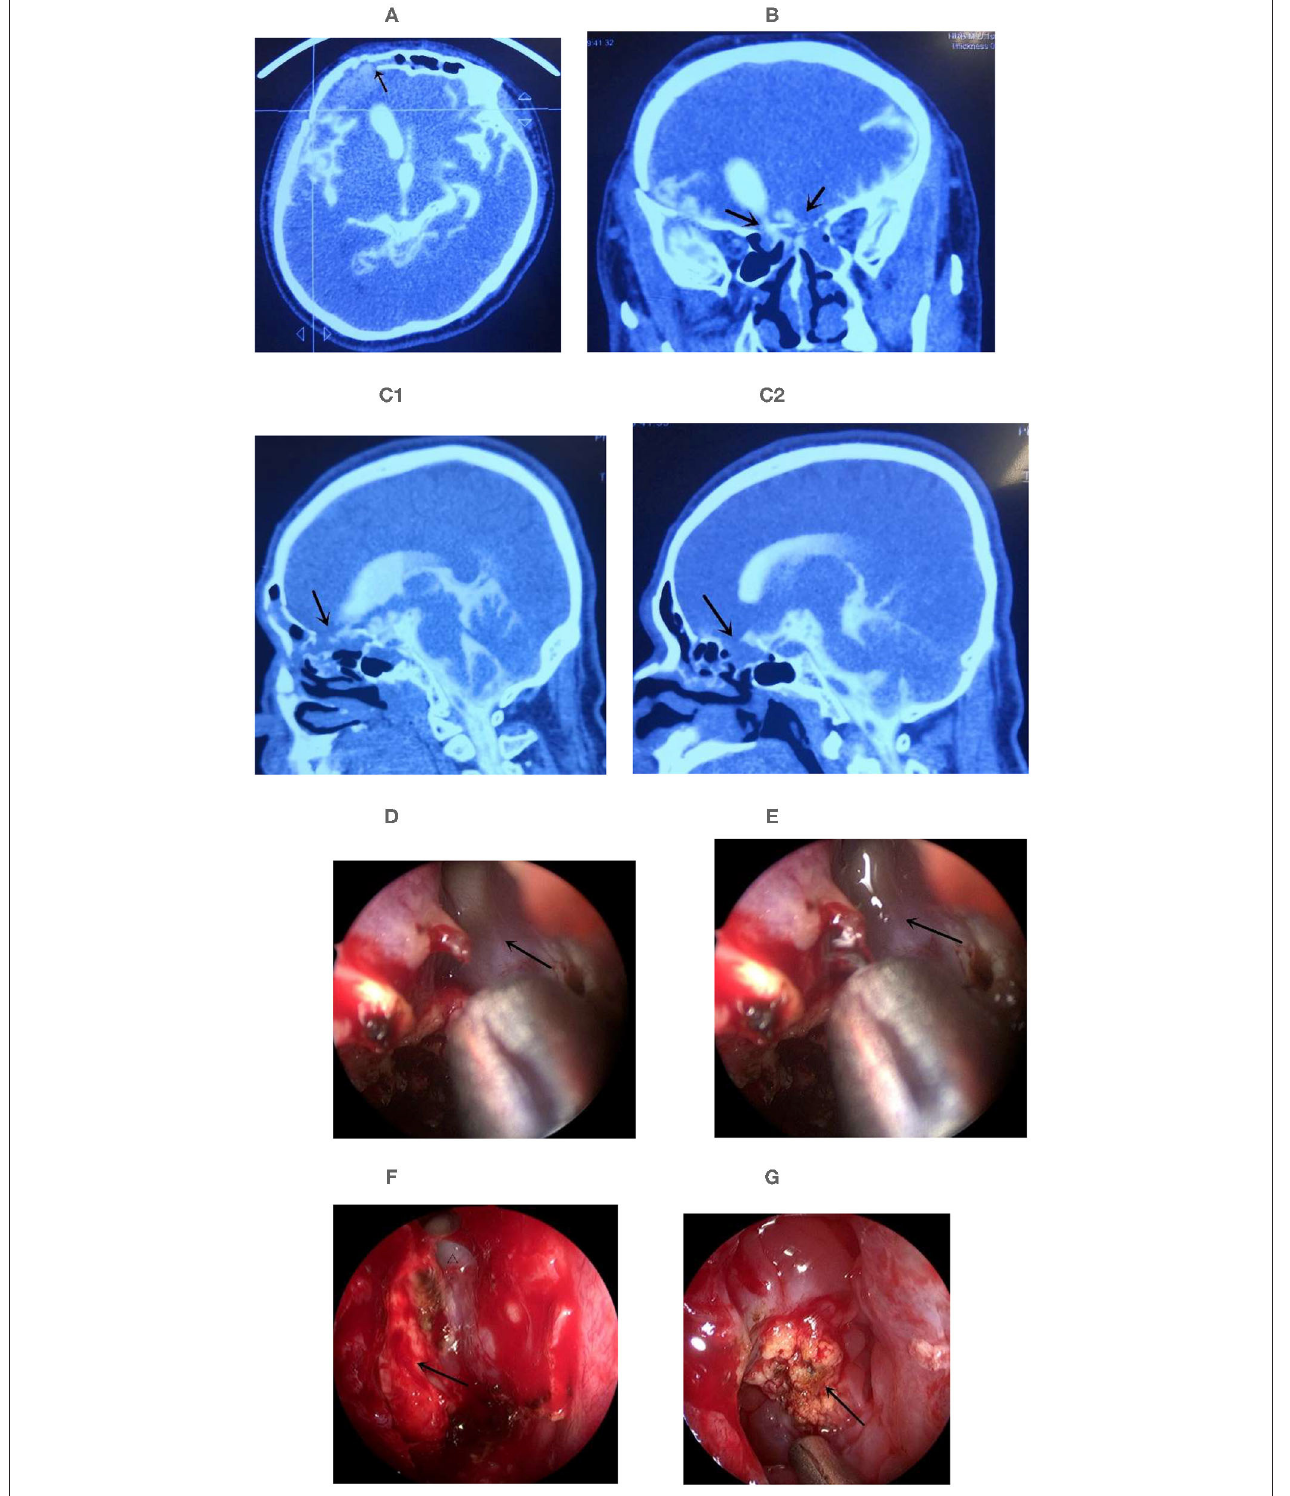
FIGURE 3 | Multiple leaks were repaired by transnasal endoscopy combined with the epidural approach. (A–C) The CTC examination located the leaks before surgery. (A) The leak was in the right frontal sinus; (B) The leak was located in the both ethmoid sinus roofs of the coronal CT. (C1) Sagital CT of right ethmoid, (C2) Sagital CT of left ethmoid. Arrow show the suspected leak. (D) No CSF leak in the right frontal sinus, arrow show the orifice of frontal sinus. (E) CSF leak was found in the right frontal sinus when intraoperative injection of 40mL normal saline through lumbar drainage to expose the leak. Arrow show the CSF in the orifice of frontal sinus. (F) Encephaloceles in the right ethmoid sinus roof leakage, arrow show the encephaloceles, triangle indicated the orifice of right frontal sinus; (G) Encephaloceles in the left ethmoid sinus roof leakage, arrow show the encephaloceles ( Supplementary Video 2 ).